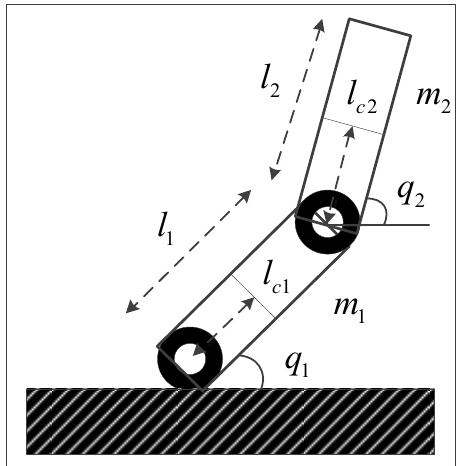
Figure 1. Double-joint manipulator model.